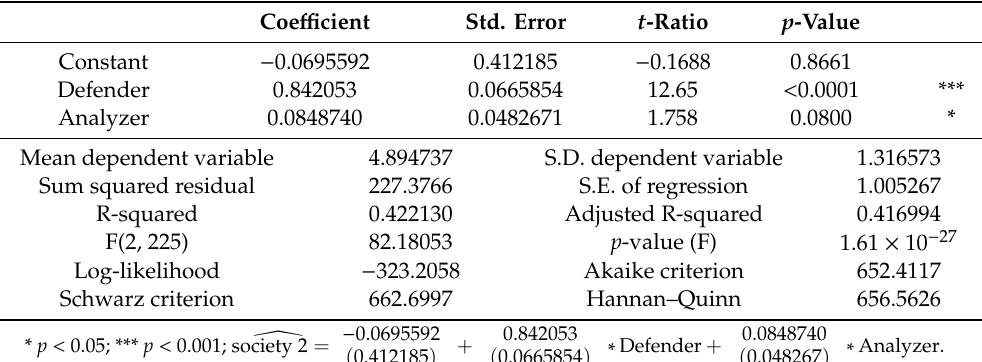
Table 6. Model 6: OLS, using observations 1–228. Dependent variable: Society